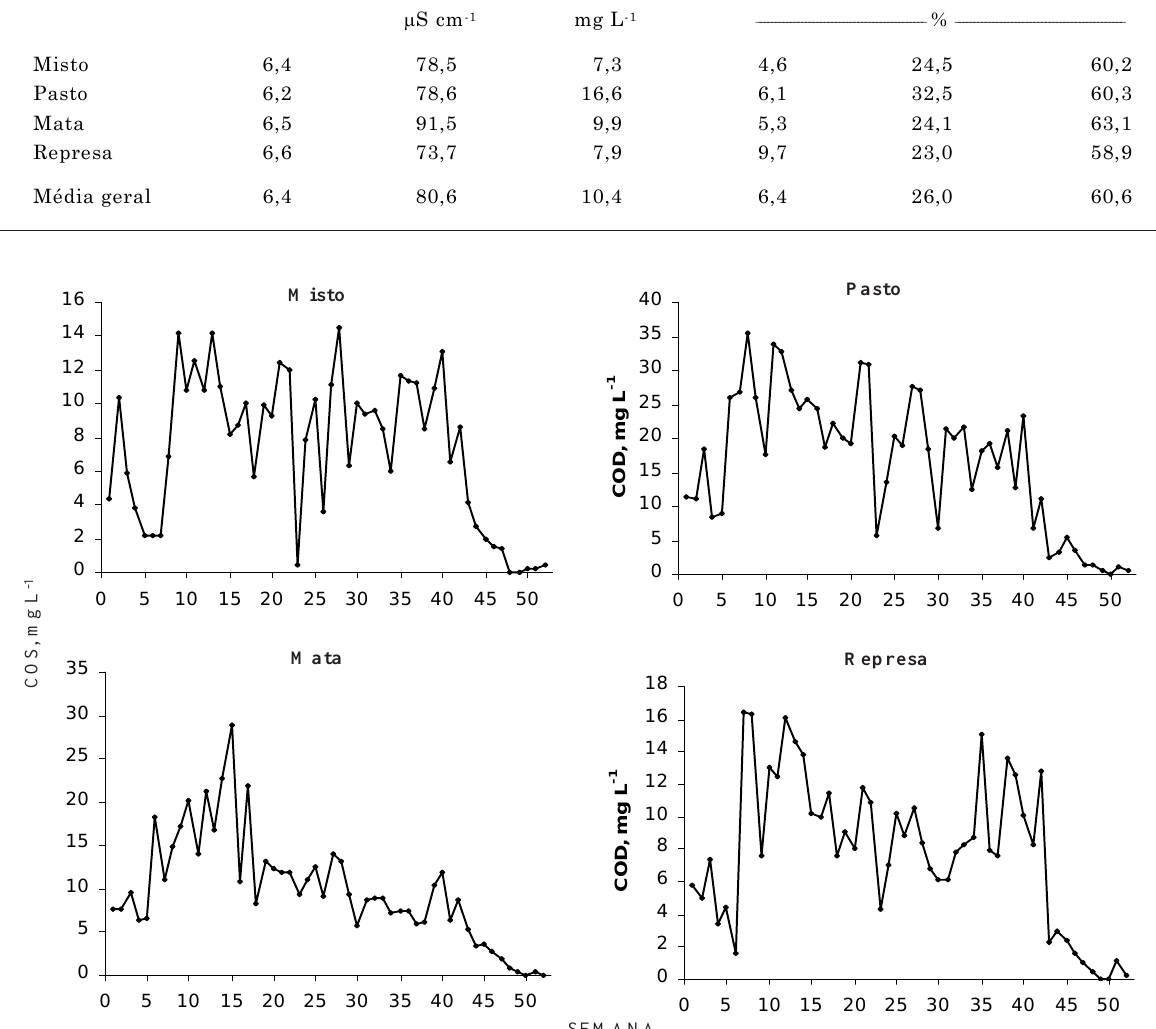
Figura 8. Concentração média semanal de carbono orgânico solúvel no deflúvio de cursos da água no período de 01/08/1996 a 31/07/1997. Média de três